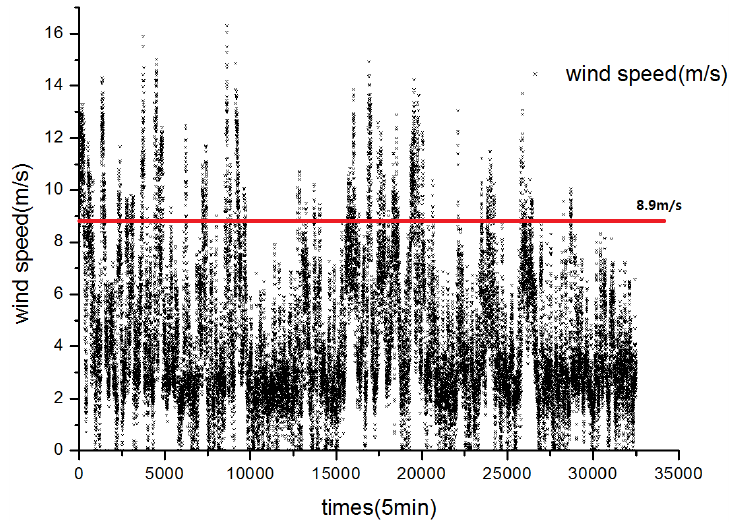
Figure 8. Wind speed during test. Table 6. Wind speed during test.